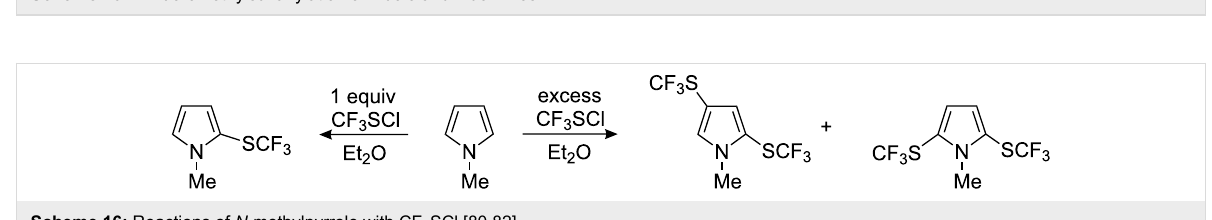
Scheme 16: Reactions of N -methylpyrrole with CF 3 SCl [80,82].